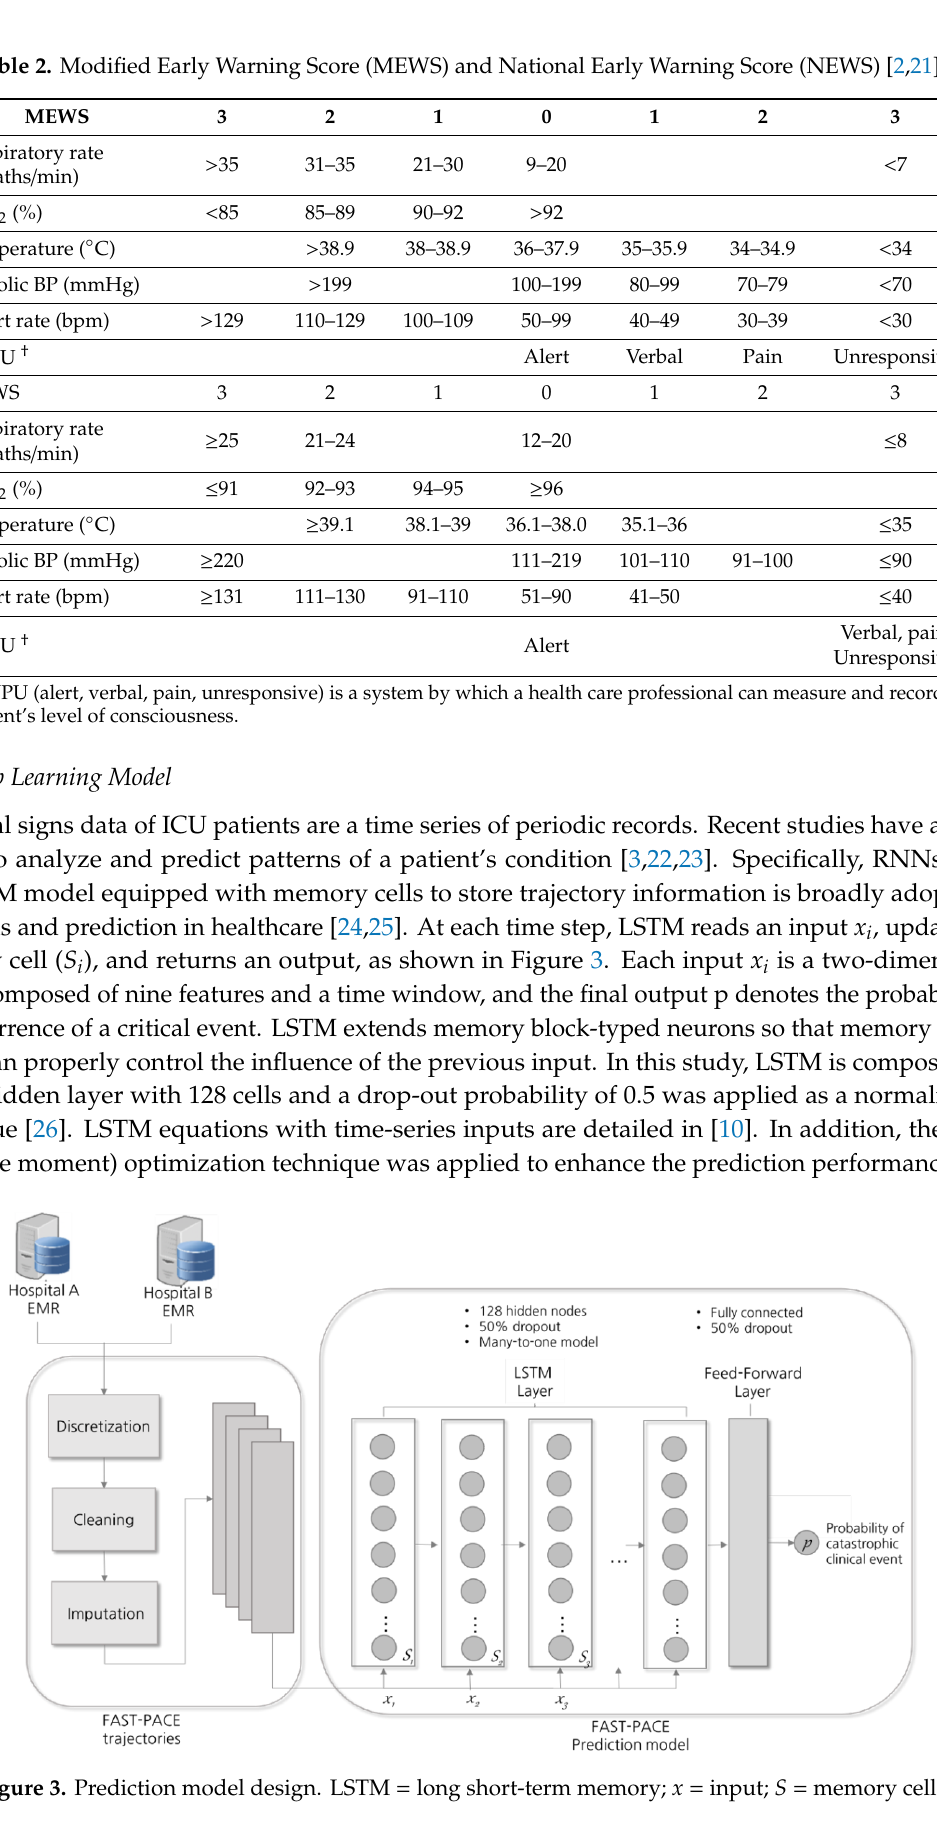
Table 2. Modified Early Warning Score (MEWS) and National Early Warning Score (NEWS) [2,21].